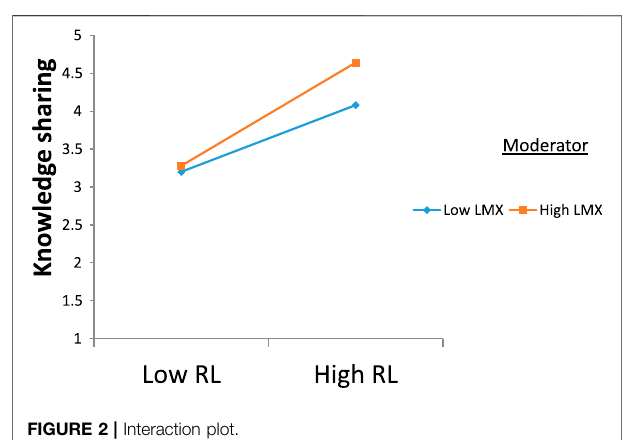
FIGURE 2 | Interaction